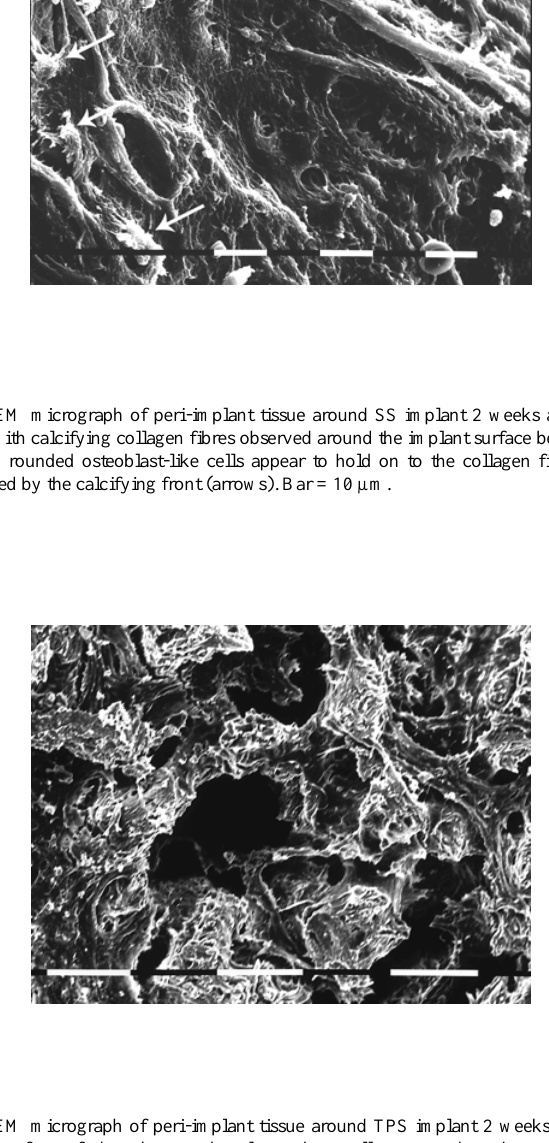
FIGURE 5 . SEM micrograph of peri-implant tissue around TPS implant 2 weeks after surgery. A very irregular surface of short bone trabeculae orthogonally arranged to the metal surface with cellular lacunae and small marrow spaces is evident in direct contact with the implant surface between 2 threads. Bar = 10